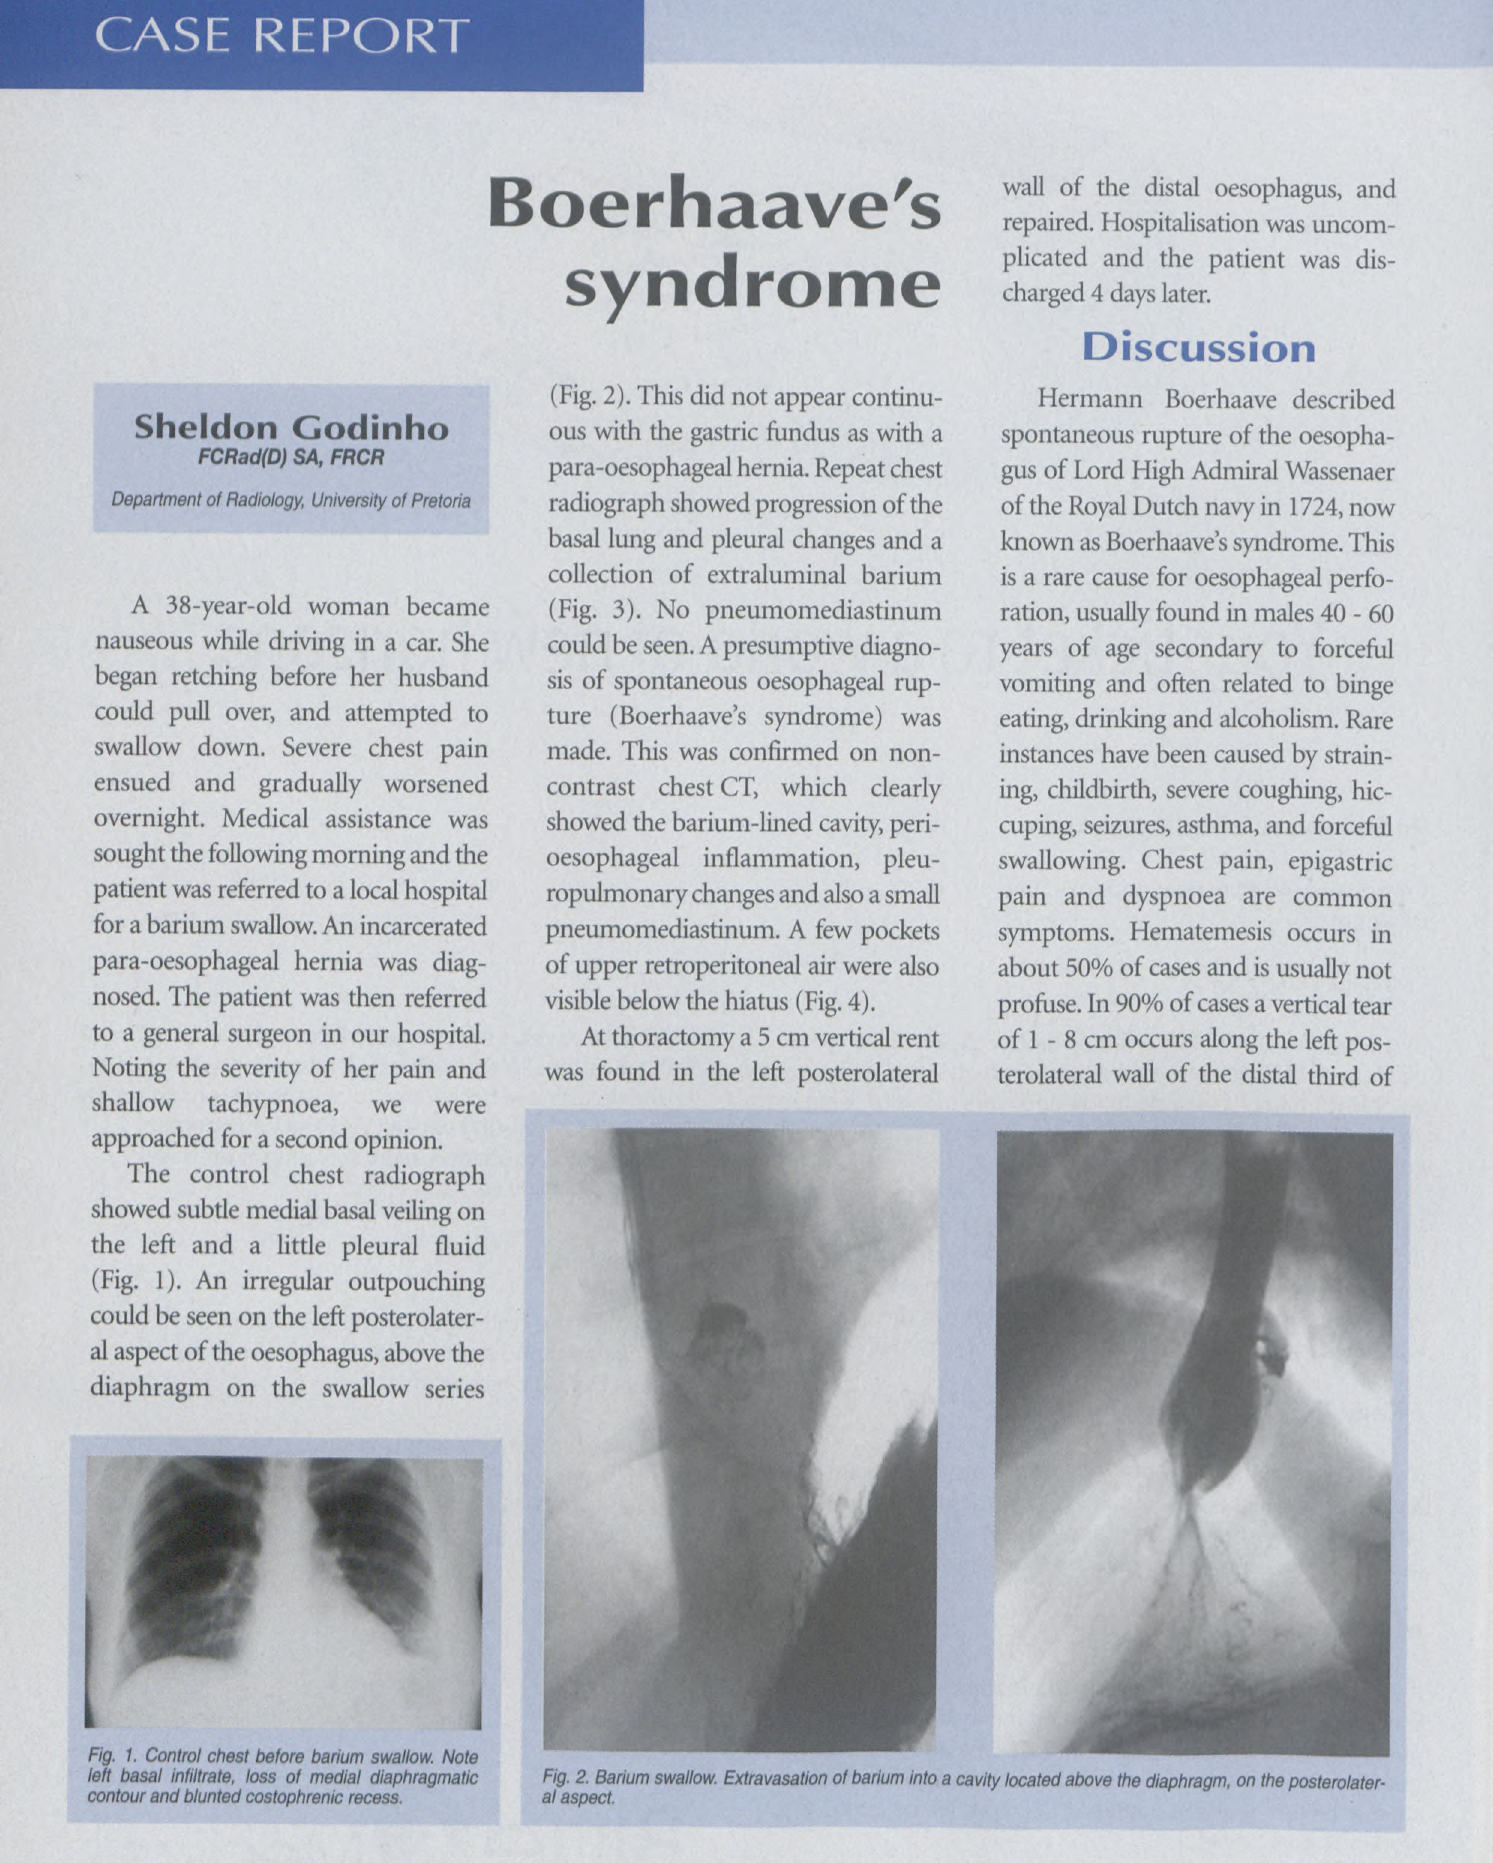
Fig. 2. Barium swallow. Extravasation of barium into a cavity located above the diaphragm, on theposterolater- al